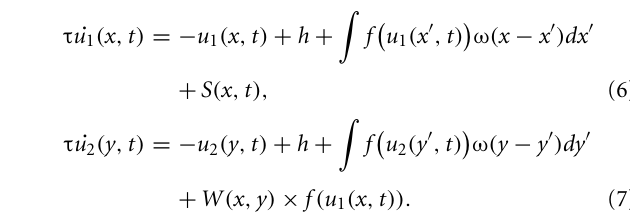
FIGURE 3 | The neuromorphic Dynamic Vision Sensor [eDVS, Conradt et al. (2009)] on a pan-tilt unit, the output of the eDVS, integrated over a time window of 100ms, and the instantaneous output of the perceptual